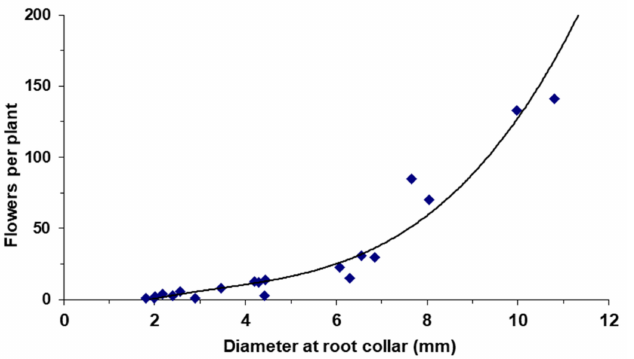
Figure 2. Relationship between root diameter (RD), measured 0.5 cm below the root collar, and the number of flowers produced per plant (PF). PF = 0.312 RD 3 − 3.181 RD 2 + 15.342 RD − 19.825 (R 2 = 0.986; p <